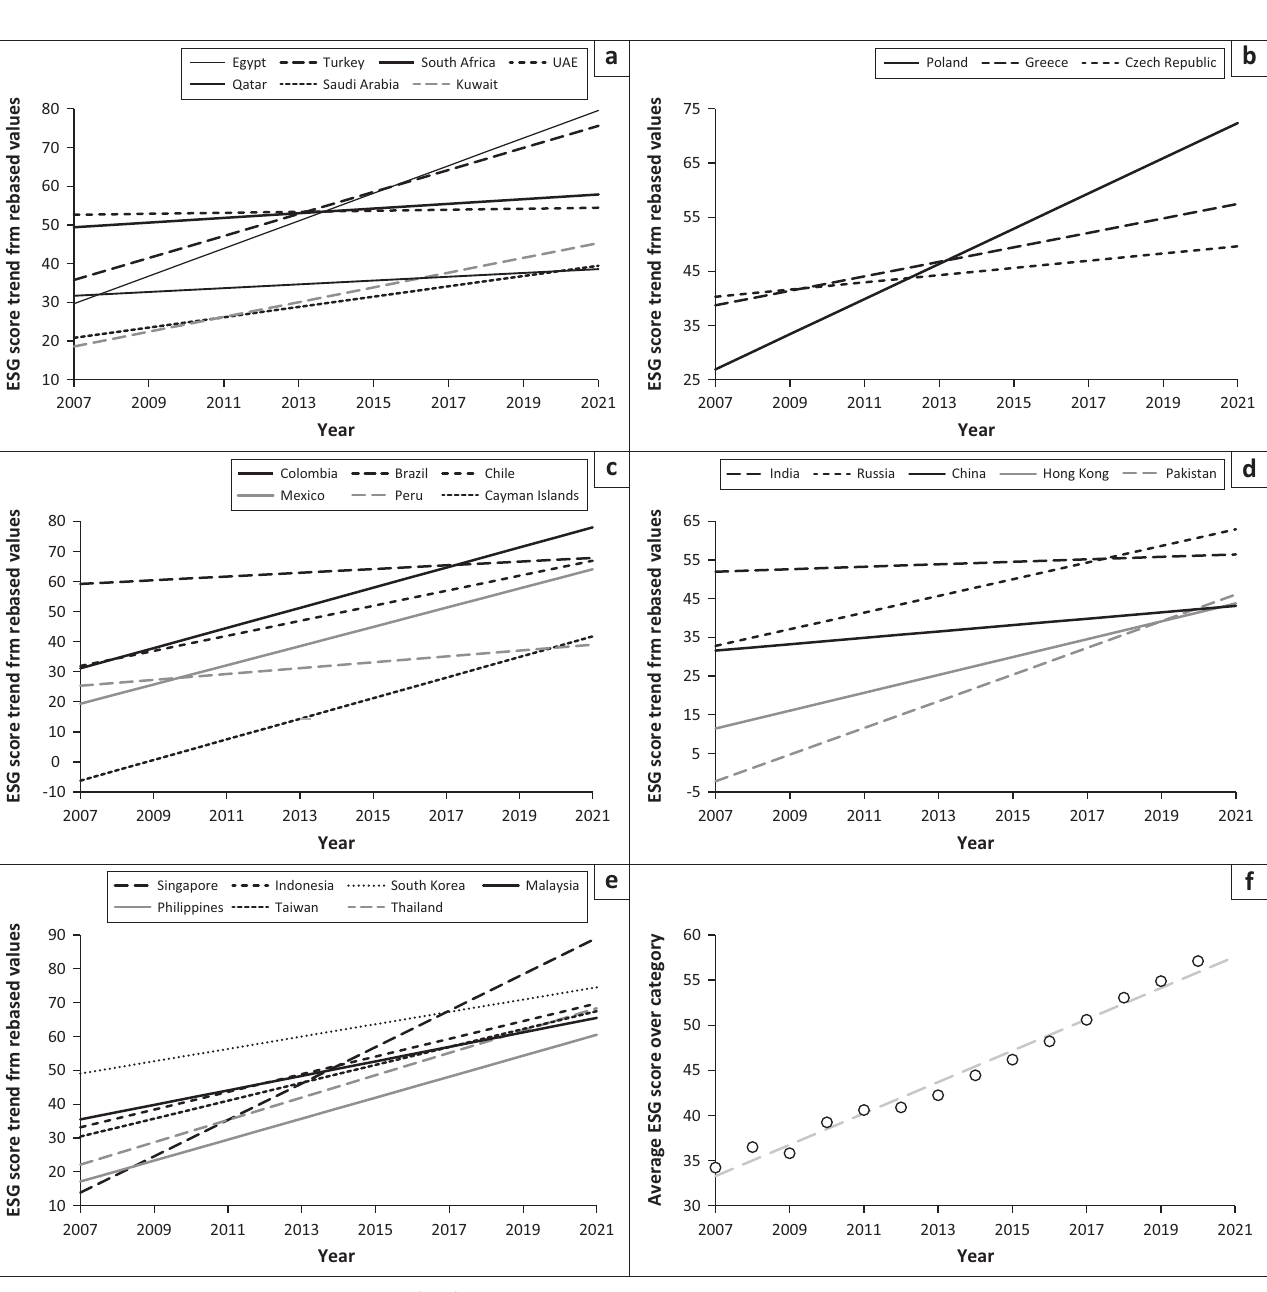
FIGURE 2: Environmental, social and governance (ESG) score trends for various global developing market regions: (a) Middle East and Africa, (b) Europe, (c) South America, (d) Asia, (e) Southeast Asia and (f) the emerging economy average ESG score over time. Vertical scales are